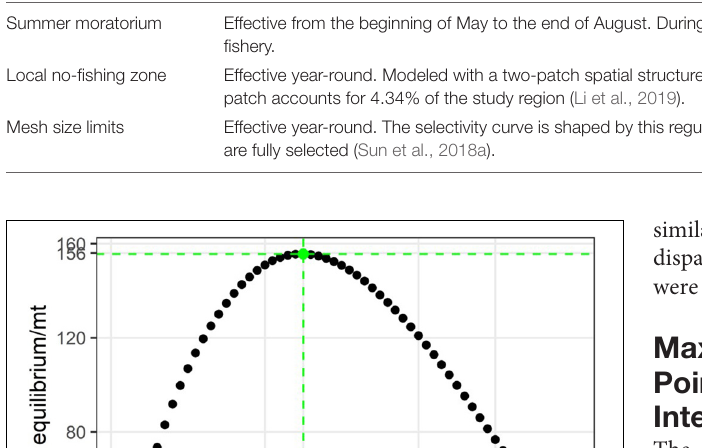
TABLE 2 | Management measures simulated for the fishery. Measure Details